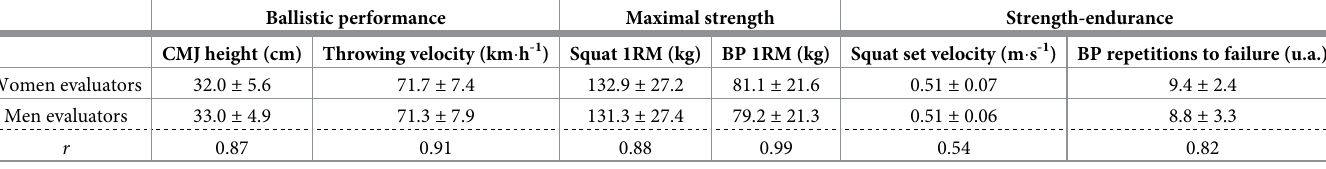
Table 1. Descriptive data of the dependent